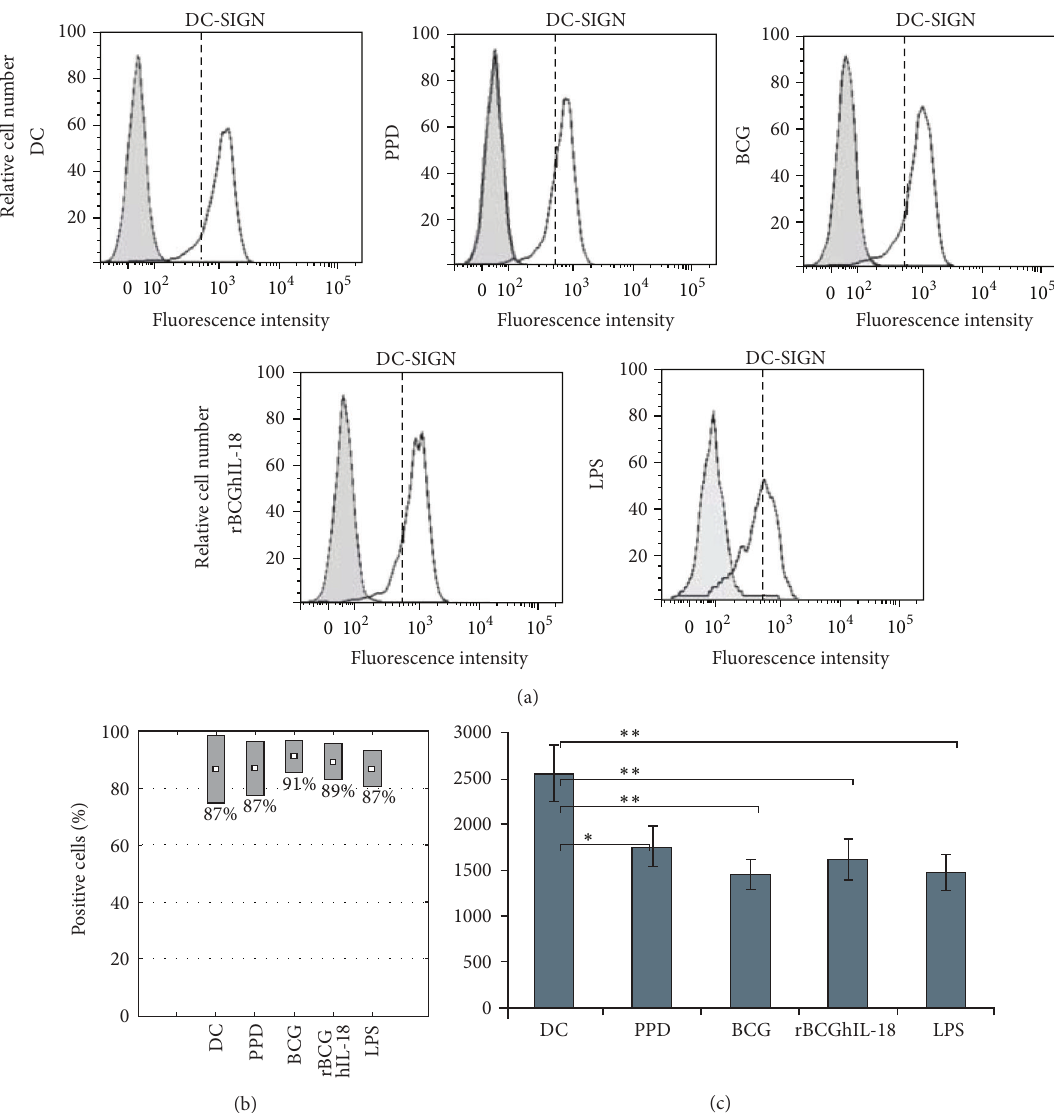
Figure 5: DC-SIGN surface expression of MoDCs. Human MoDCs were pulsed either with PPD (10 𝜇 g/mL), BCG (1: 1), rBCGhIL-18 (1:1), or LPS (1 𝜇 g/mL) for 24 h or were left unstimulated (DC). (a) One representative experiment out of 20 independent ones is shown. Grey histograms represent the cell reactivity to fluorochrome-matched isotype control antibodies. The white histograms represent the reactivity with the anti-DC-SIGN antibody. The vertical broken lines represent the upregulation obtained by LPS stimulation; (b) percentage of positive cells with the DC-SIGN expression; (c) median fluorescence intensity (MFI) values (median ± SEM of 20 independent donors). Fluorescence intensity was calculated by the MFI of the receptor expression from which the MFI obtained with a nonrelevant, isotype-matched antibody was substracted. Statistical analyses were performed using the Kruskal-Wallis test. ∗ 𝑃 < 0.05 ; ∗∗ 𝑃 < 0.01